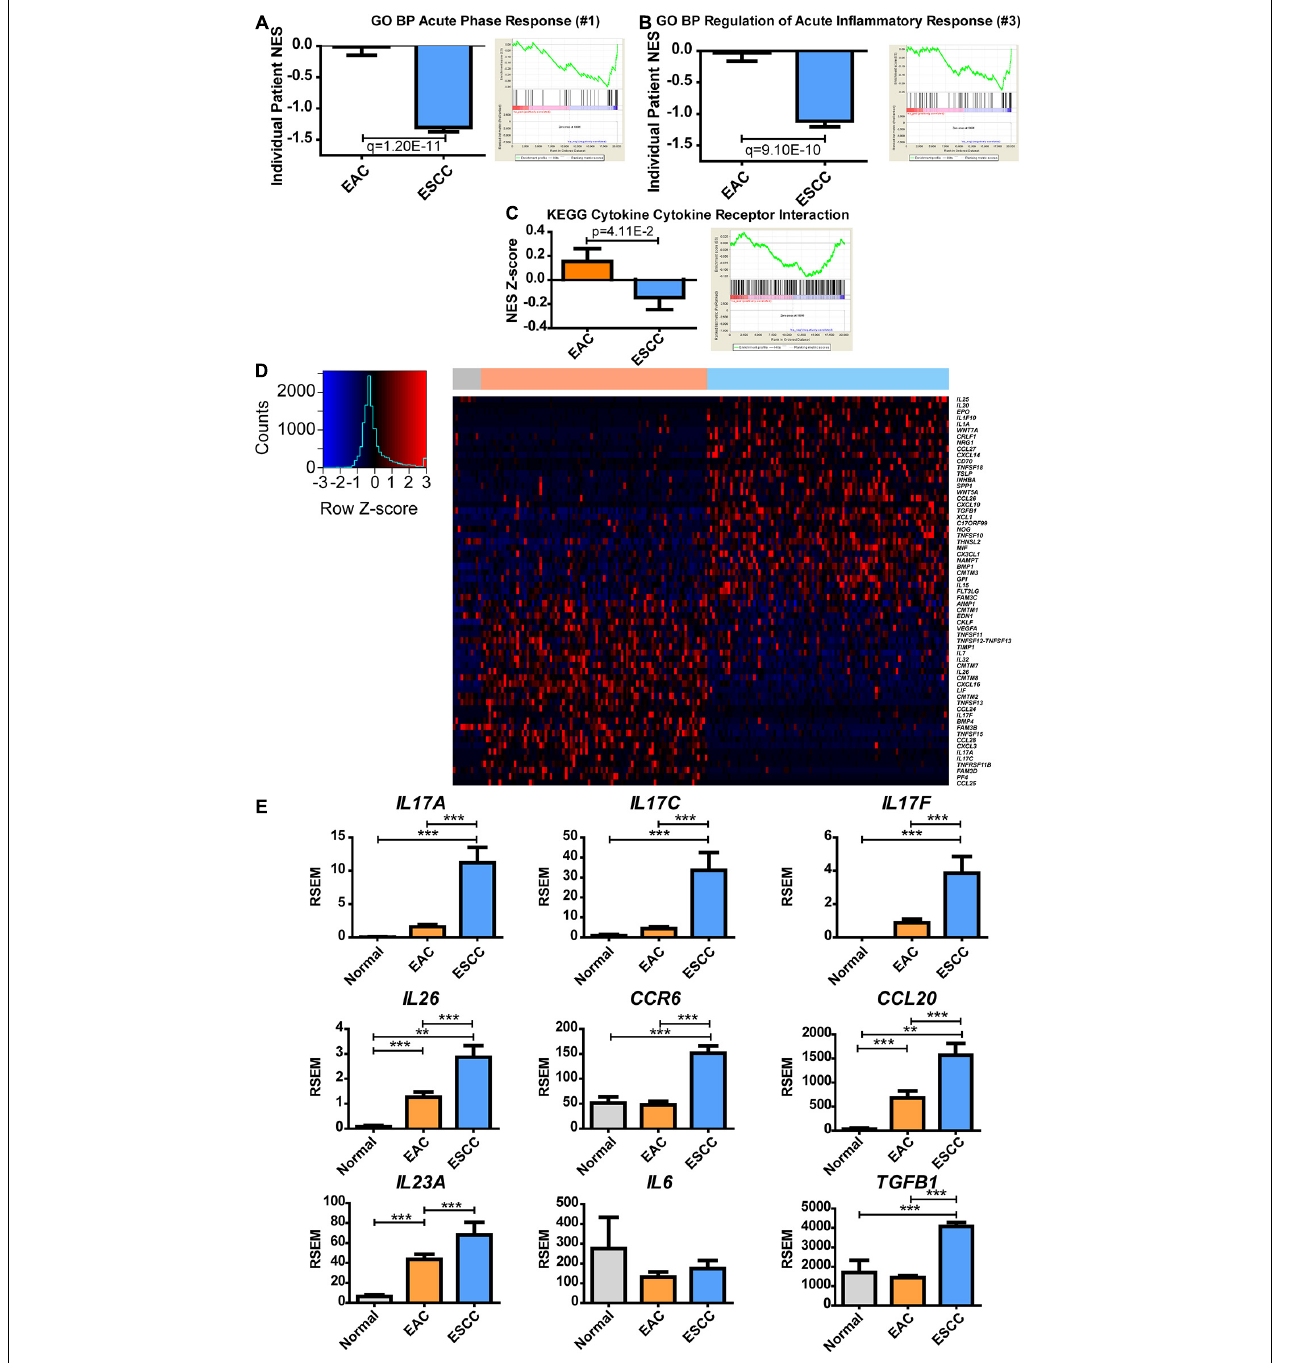
FIGURE 4 | Esophageal squamous cell carcinoma (ESCC) and esophageal adenocarcinoma (EAC) histological subtypes show distinct inflammatory responses. Normalized enrichment score (NES) was calculated for each patient’s tumor by comparing each patient’s expression to the normal adjacent tissue average expression (left) and as a group against the average of each subtype (right) for Gene Ontology biological processes (GO BPs). (A) The largest fold change of ESCC compared to EA was discovered to be acute phase response, (B) while the third was regulation of acute inflammatory response. (C) The same calculation was made for the Kyoto Encyclopedia of Genes and Genomes (KEGG) database to show the NES Z-score (left) and average group enrichment (right). (D) Heatmap mRNA Z-scores of differentially expressed genes (Student’s t -test, p < 0.05) for GO term “cytokine activity” (GO: 0005125). The color bar on top indicates normal (gray), EAC (orange), and ESCC (blue). (E) mRNA expression levels for cytokines of interest relating to a Th17 signature. Differences in enrichment scores were calculated by the Student’s t -test and corrected with a Benjamini–Hochberg correction when examining multiple pathways in GO. Gene expression was compared with Kruskal–Wallis H test with Dunn’s multiple comparison test between all columns. ** p < 0.01, *** p < 0.001.